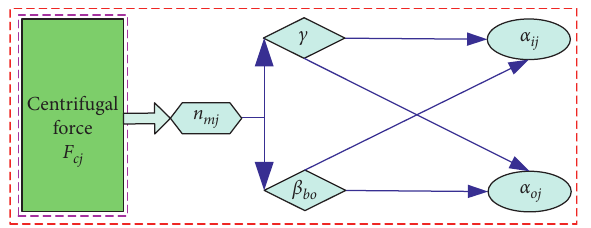
Figure 4: Analysis of the variable transfer relationship of cen- trifugal force F cj .